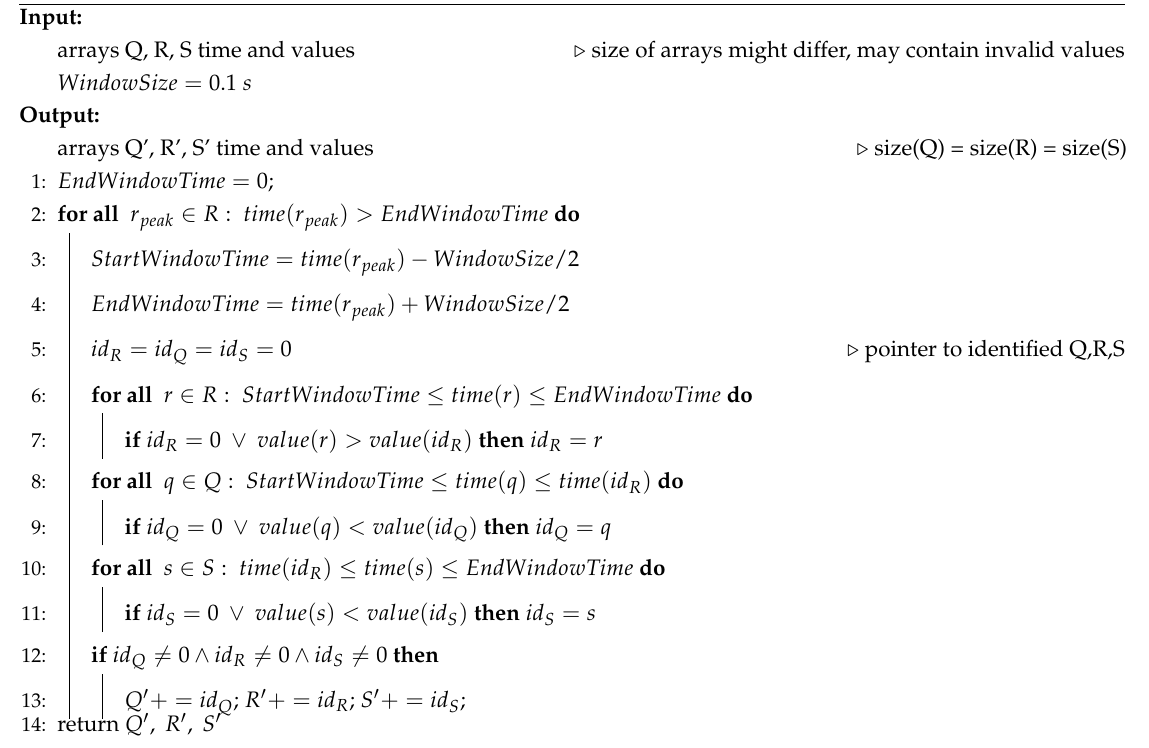
Algorithm 1 Model-based Validation on detected QRS